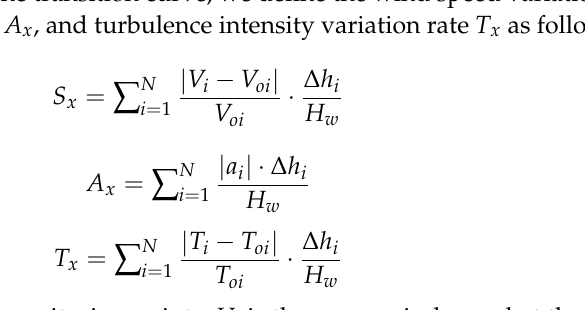
Figure 7. Mesh for the transition section.